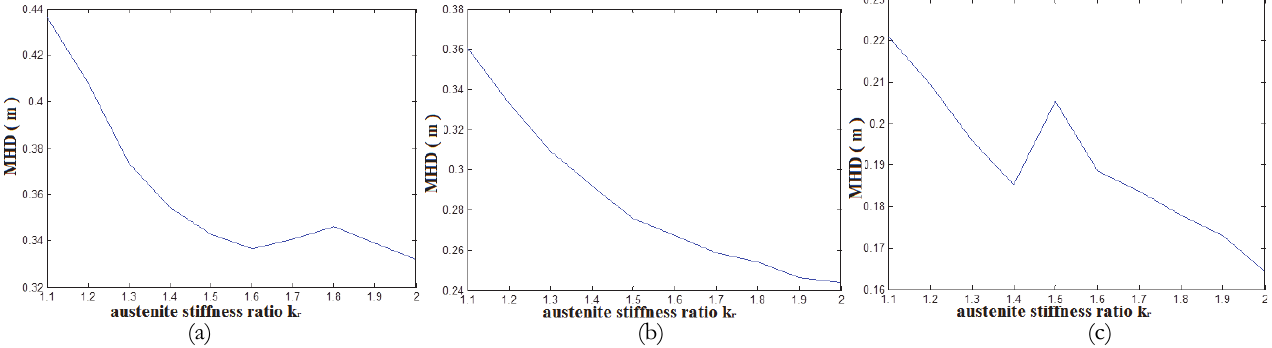
Figure 14: MHD versus variable (kr) values under different periods T1, (a) T1 = 1.5 sec; (b) T1 = 1.0 sec; (c) T1 = 0.6